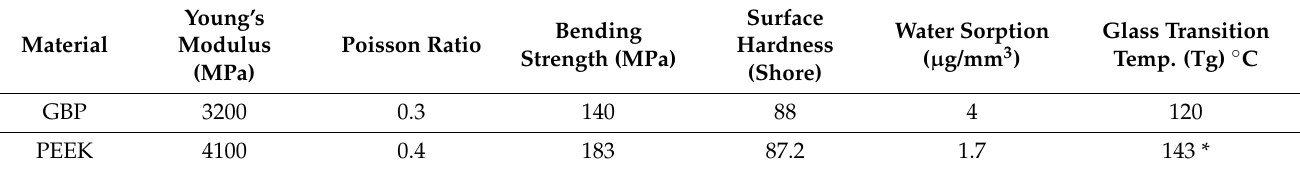
Table 1. Material properties of the tested polymers